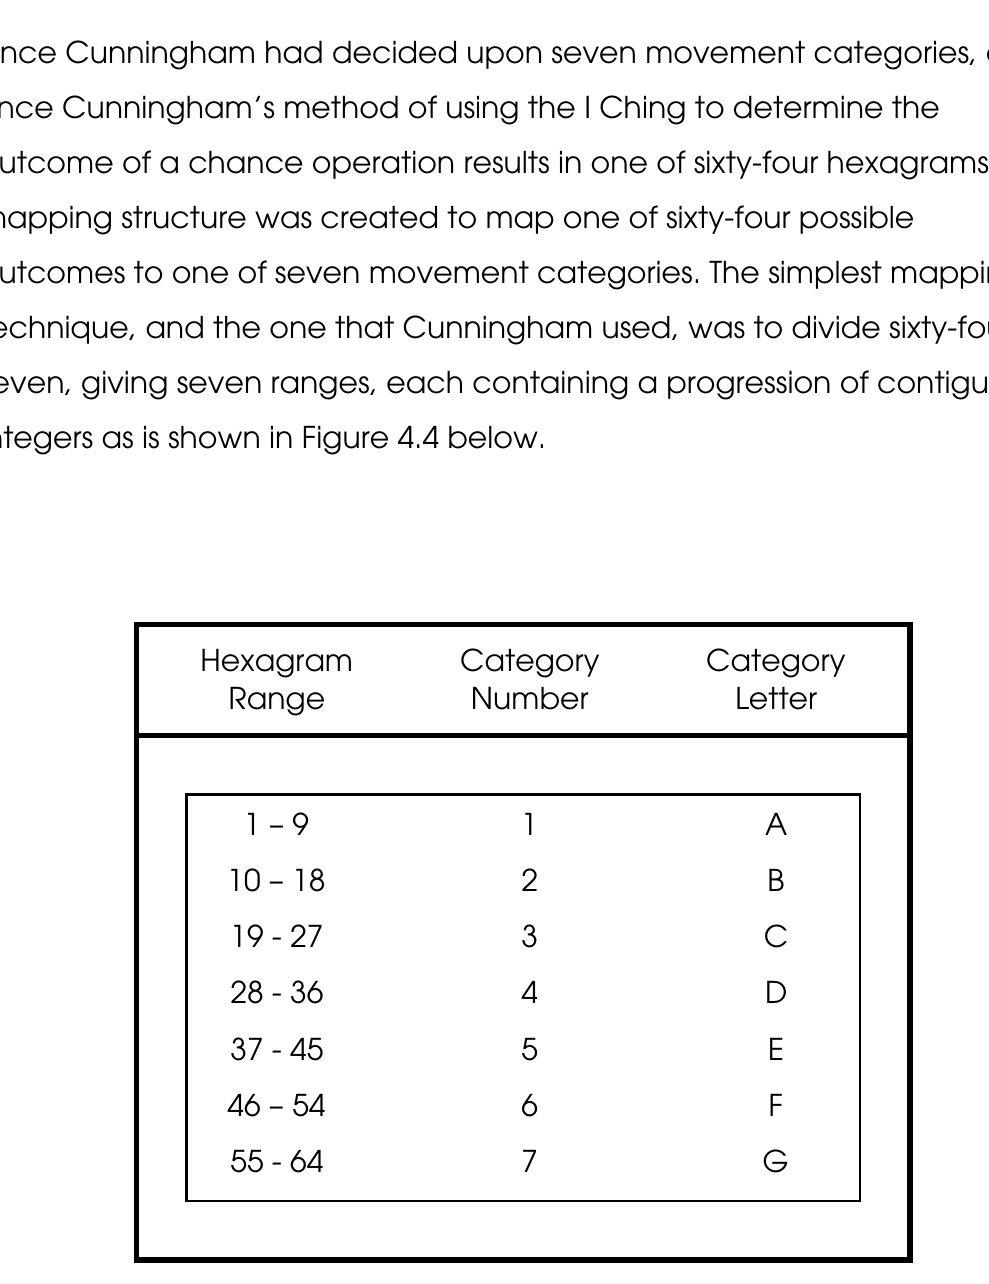
Figure 4.4 Mapping Hexagrams to Movement